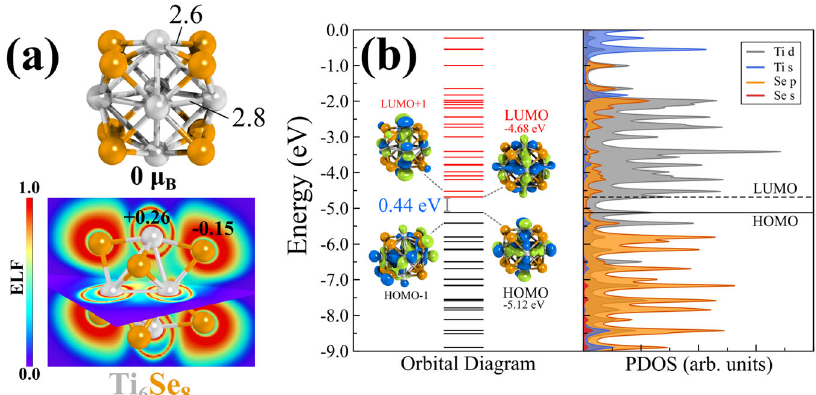
Fig. 1 Structure and electronic properties of Ti 6 Se 8 cluster. a Ground state optimized structure of Ti 6 Se 8 cluster (bond distances are in Å) and the contour plot of the electron localization function (ELF) along with the Hirshfeld charges on the Ti and Se atoms ( b ) the molecular orbital (MO) and the projected density of states (PDOS) diagram of Ti 6 Se 8 cluster. Isosurfaces of a few important orbitals are also shown.